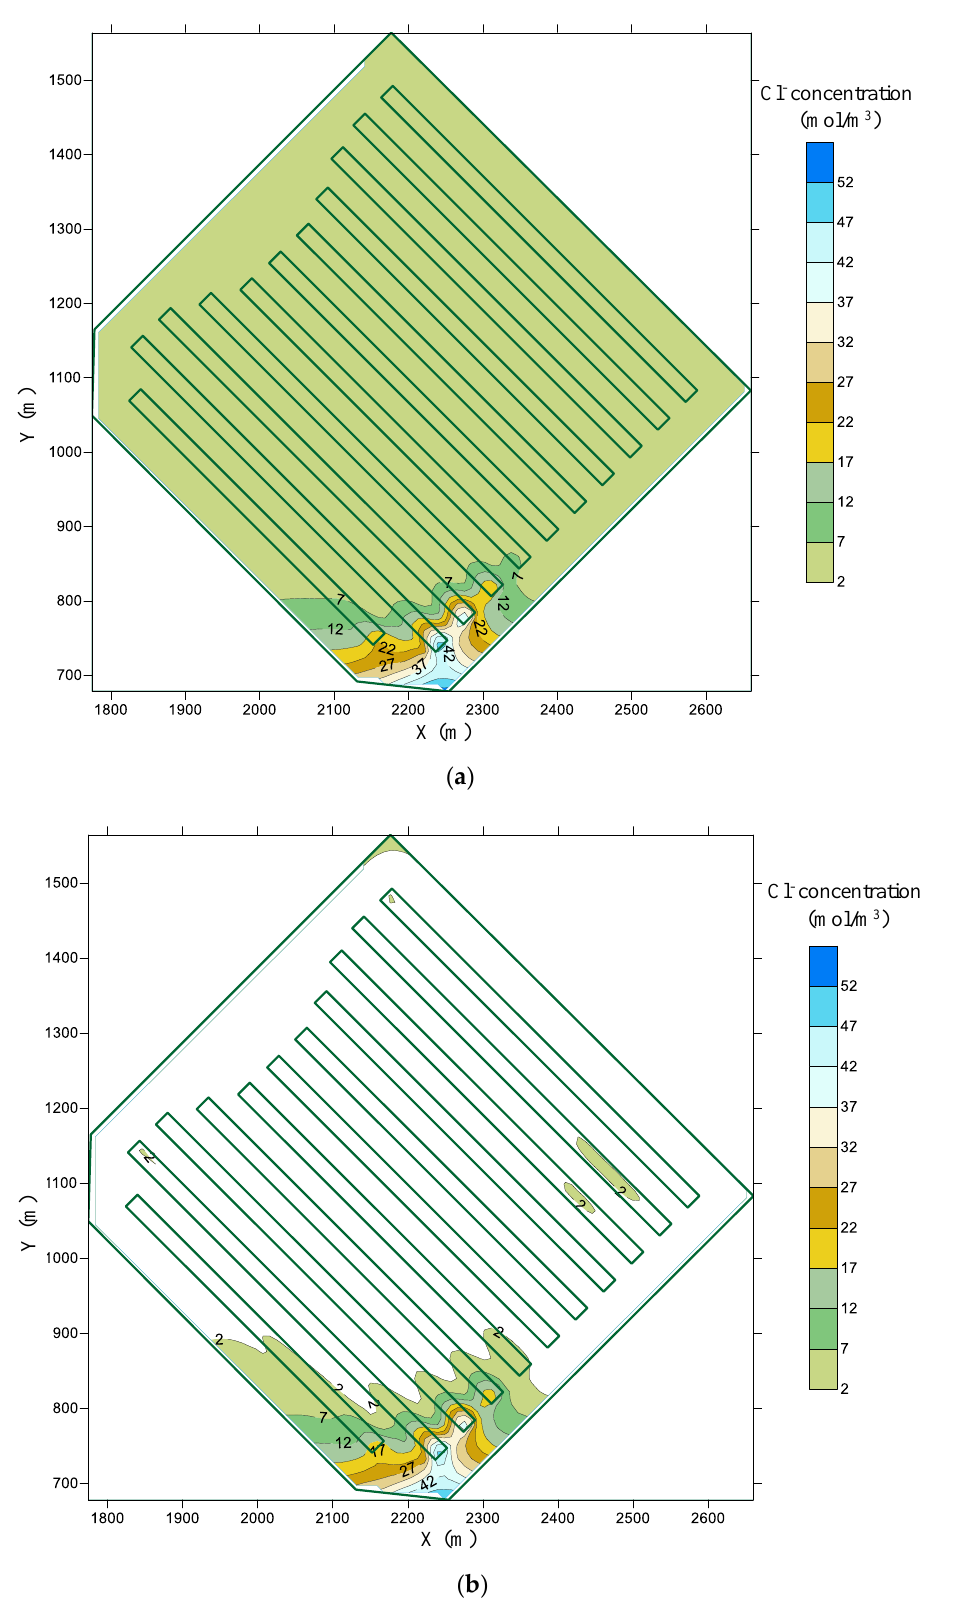
Figure 18. Cl − concentration at the cavern bottom ( − 92 m elevation) after 50 years operation: ( a ) groundwater injection in water curtain system; ( b ) freshwater injection in water curtain system.